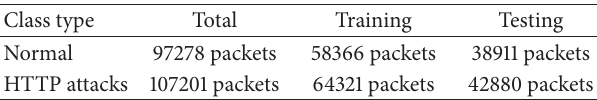
Table 2: Cloud dataset description.